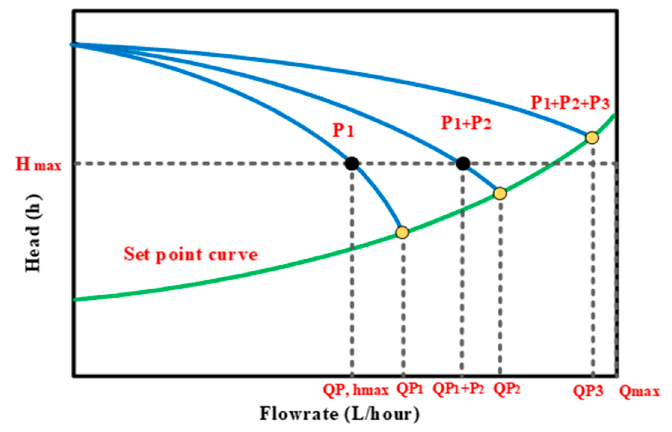
Figure 7. Parallel pump operational curve.